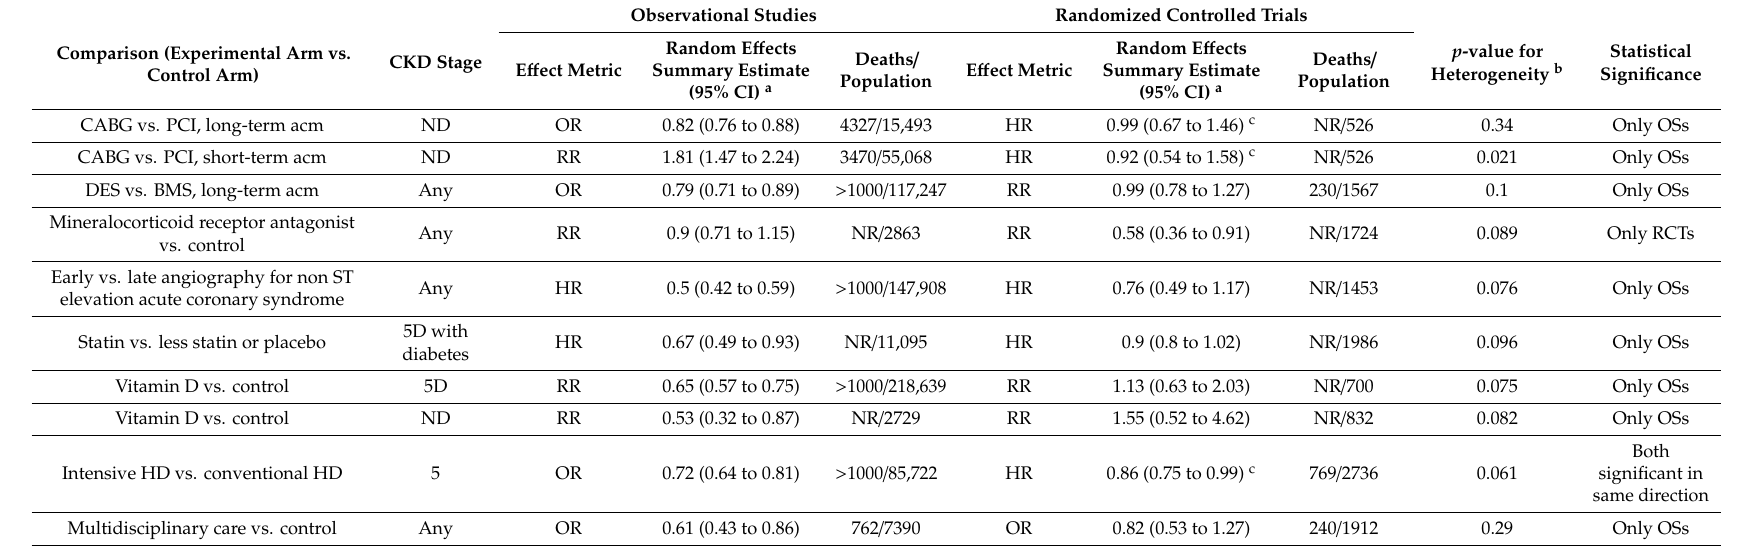
Table 3. Comparisons of e ff ect of treatment on all-cause mortality between evidences from observational studies and randomized controlled trials.